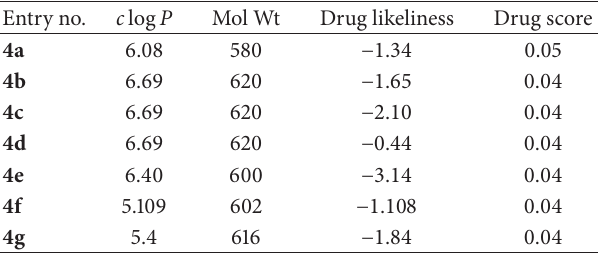
Table 3: Molecular Osiris property of compounds 4a – g . Entry